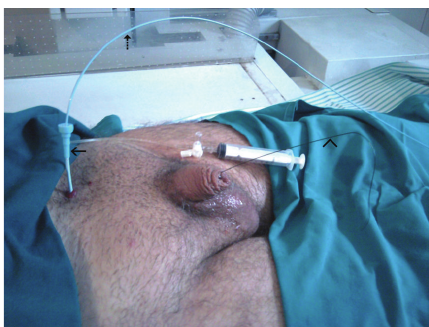
Figure 2: Demonstration of the technique after the replacement of the suprapubic catheter with the angiographic sheath (arrow). The angiographic catheter (dotted arrow) and the guidewire (arrow- head) have been inserted through the angiographic sheath into the bladder. The guidewire has negotiated the stenosis and has been externalized through the external urethral orifice.